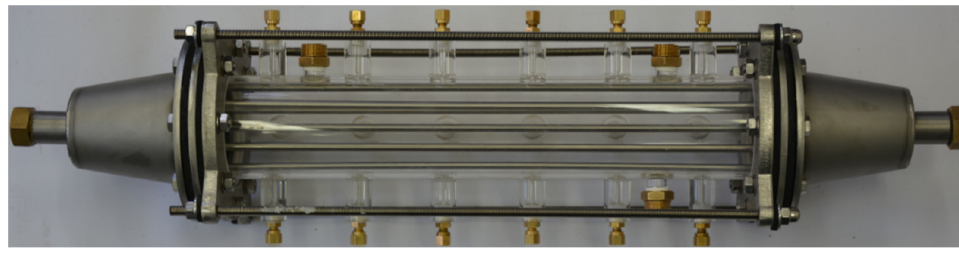
Figure 2. View of the tested LHSS .